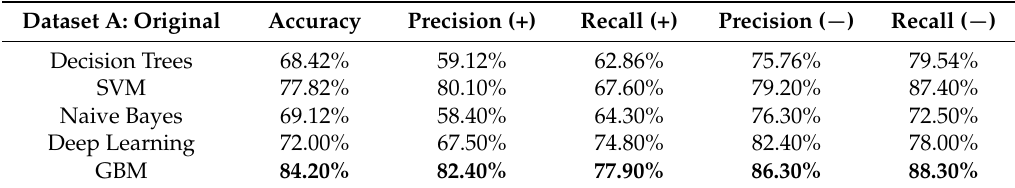
Table 2. Performance of GBM and other benchmarking methods for Dataset A: original. GBM, Gradient Boosting Machine.